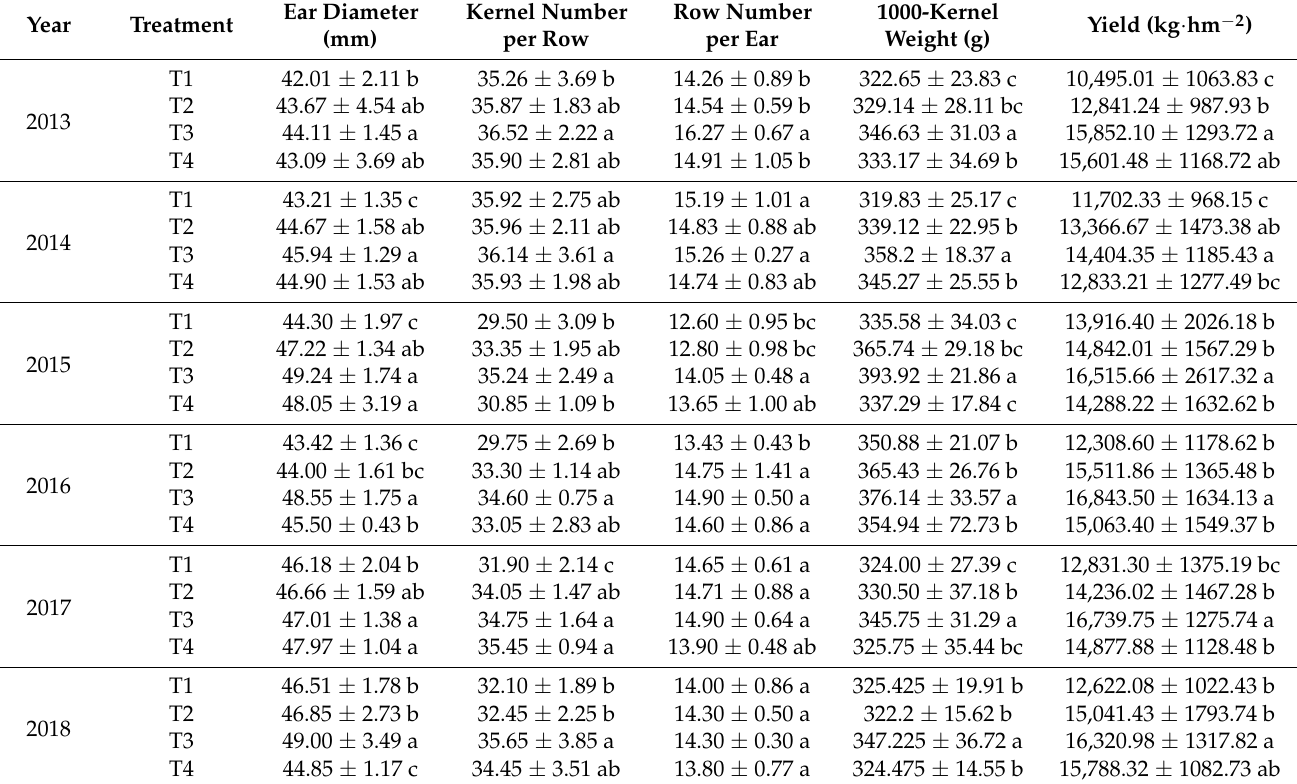
Figure 4. Dry matter accumulation of maize under drip irrigation quotas: Left is dry matter accumulation of maize at flowering stage; right is dry matter accumulation of maize at maturity stage. Note: Different lowercase letters indicate that the dry matter of each part of the maize at the same growth period is significantly different between different treatments. Table 5. Yield and components of maize under different irrigation